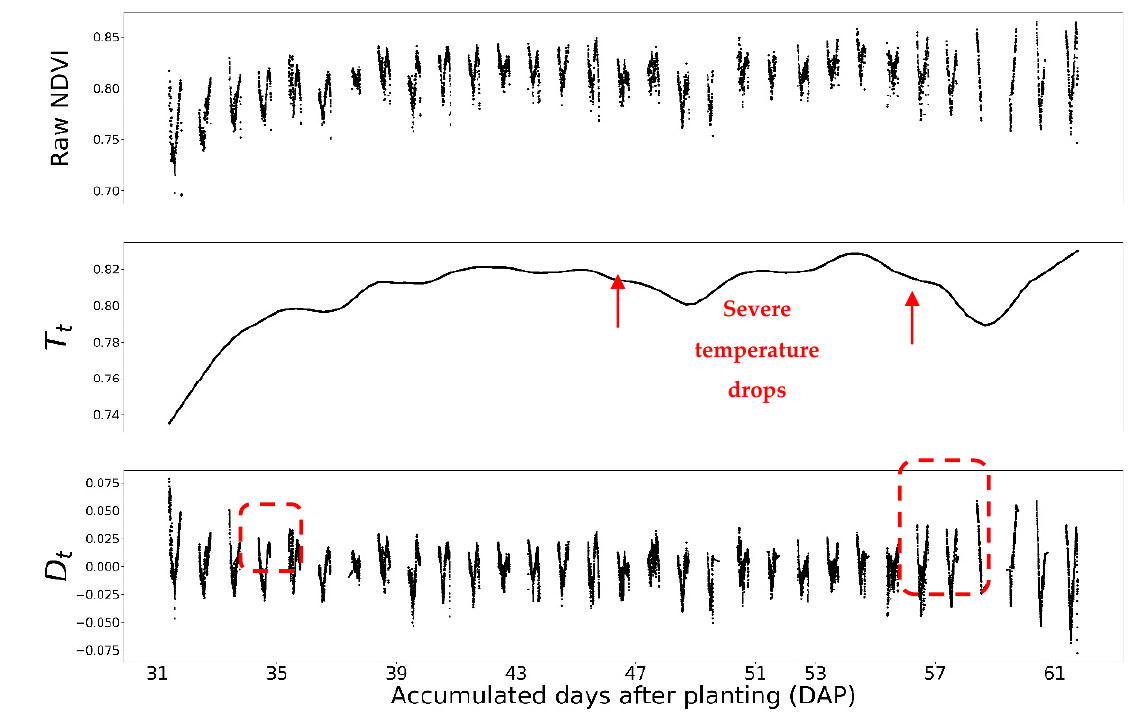
Figure 3. The NDVI of the sample dataset (G1H) from the V4 stage to the R1 stage. The raw NDVI plot was decomposed into the day-to-day trend ( T t ) and the periodic change ( D t ). The red boxes are the days with incomplete data measurements due to the extreme weather conditions, which are DAP 36, 37, 58, 59, and 60.